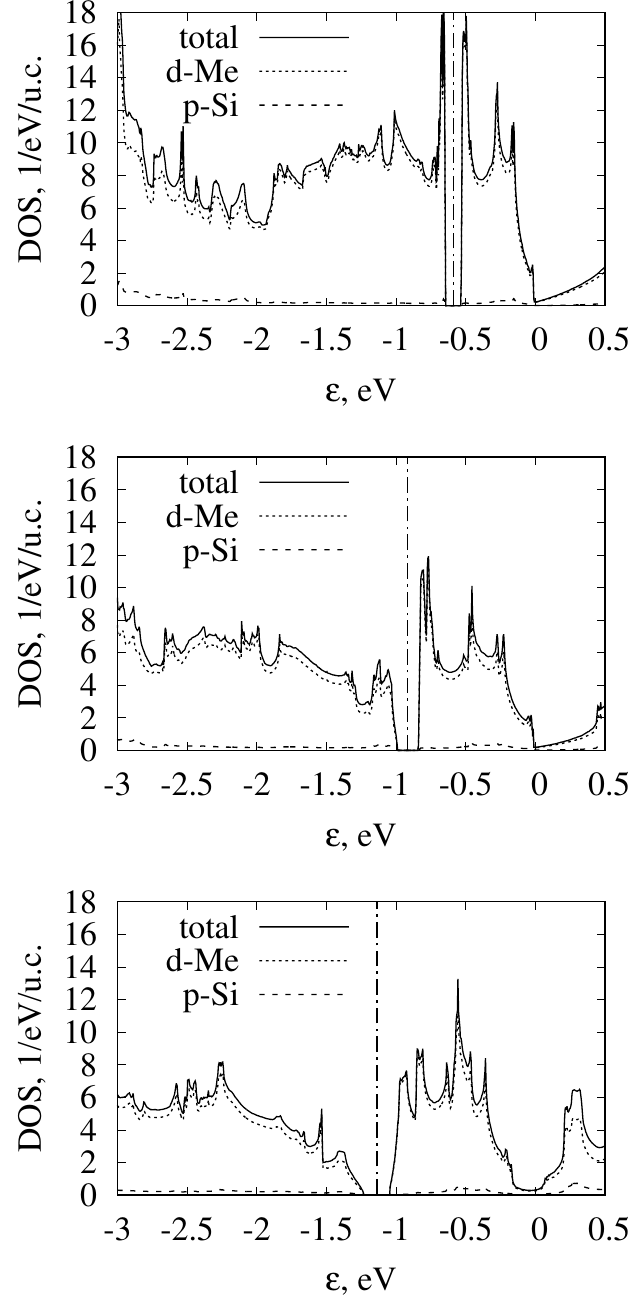
Figure 5. Total and projected density of states in FeSi, RuSi, and OsSi. Fermi level is shown by vertical dash-dotted